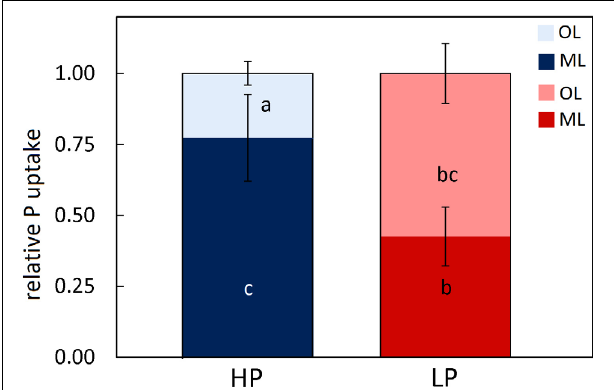
FIGURE 2 | Relative P enrichment in beech roots in the organic layer and mineral layer topsoil of beech ( Fagus sylvatica L.) forests. Intact soil cores were collected in a P-rich (HP: blue) and a P-poor (LP: red) forest, irrigated with 33 P artificial soil solution and roots from the organic layer (light blue, light red) and the mineral topsoil (dark blue, dark red) were analyzed separately after 24 h of labeling. To determine P root uptake, the rhizospheric 33 P dilutions per forest and layer were used as described under materials and methods. Data indicate means ( n = 5 ± SE). Differences among means per forest and layer were tested by GLM using Poisson distribution. Different letters indicate significant differences at p ≤ 0.05.